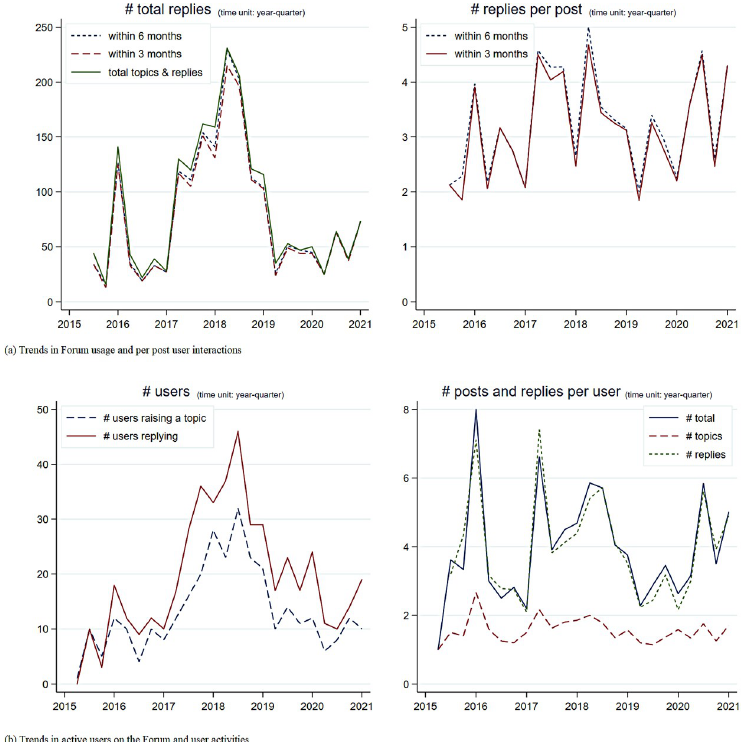
Fig 2. HBP Forum usage: Trends in posts, replies, and users. Note: Panel (a) depicts aggregate utilization of the Forum at a quarterly-level to the first quarter of 2021. Panel (b) offers a complementary view of the data from users’ perspective and shows aggregate user activity over time, both at the extensive margin (i.e., # active users) and at the intensive margin (i.e., # posts and replies per active user) per quarter.